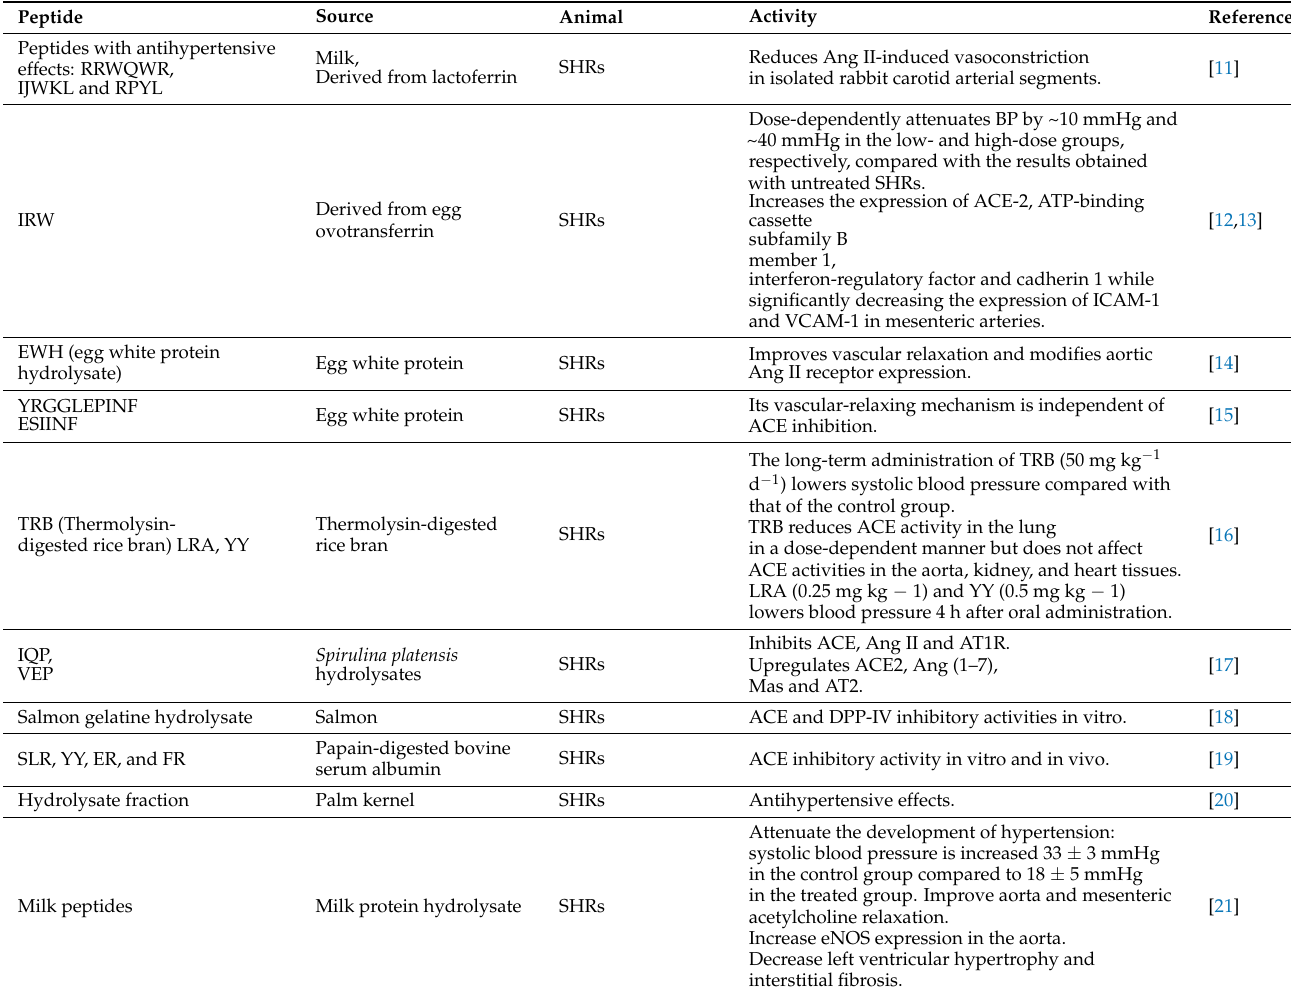
Table 1. Examples of food protein-derived bioactive peptides and their mechanisms of action. ABCB-1: ATP-binding cassette subfamily B member 1; ACE: angiotensin I-converting enzyme; Ang II: angiotensin II; AT1R: angiotensin II